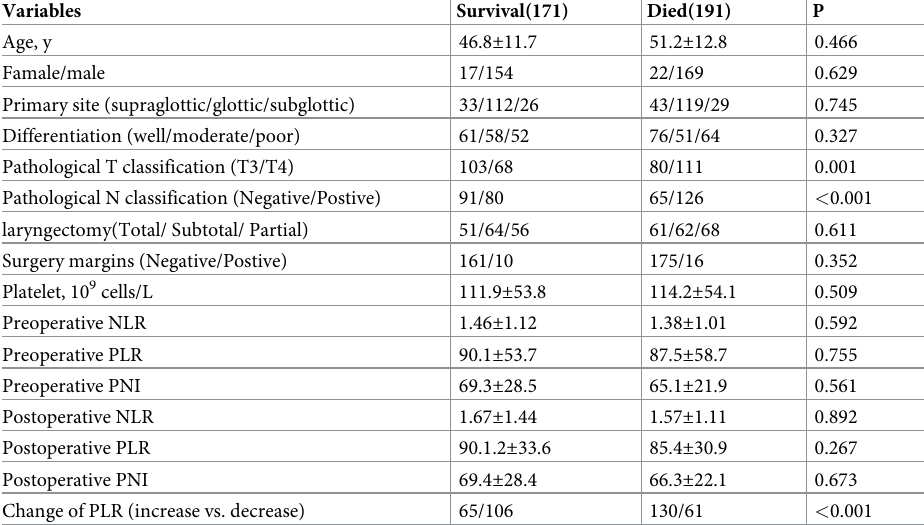
Table 4. Factors associated with postoperative survival in the univariate analyses. Variables